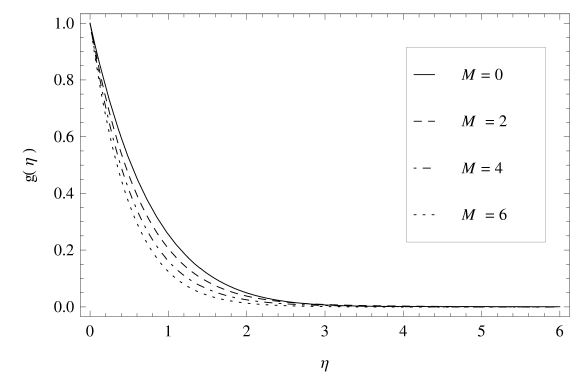
Fig. 10: The influence of a parameter M on g ( η ) for We = 0.5, α = 2, λ = 0.2, f = 0.2 and (cid:126) = −0.1 w